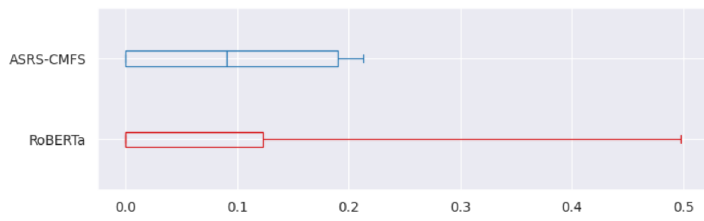
Figure 10. Boxplot for the anomaly “No specific Anomaly occurred”.